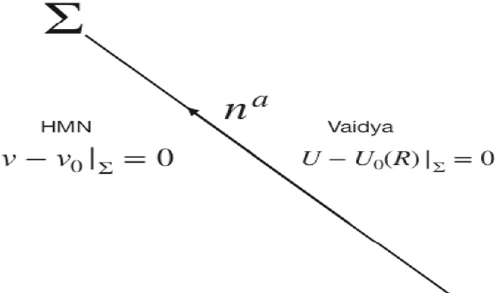
Fig. 1 Null hypersurface